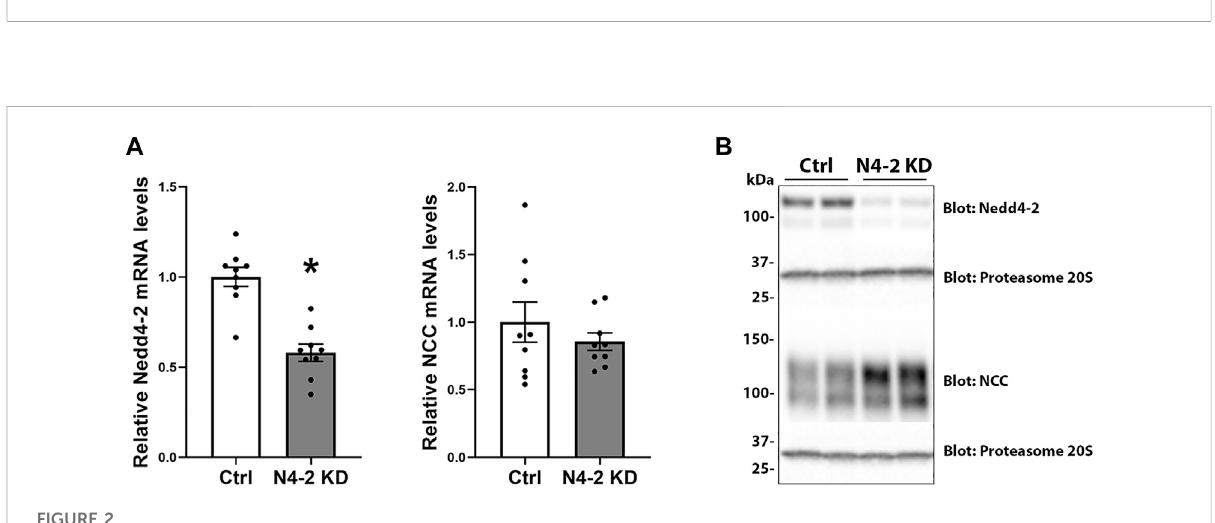
FIGURE 1 Nedd4-2interactswithNCC. (A) ThreeE3ubiquitinligaseswerefoundinaY2HassaywiththeC-terminusofNCCasbait.Nedd4-2,Nedd4,and Pdzrn3. The orange line represents the Selected Interaction Domain (SID), corresponding to the amino acid sequence shared by all prey fragments matching the same reference protein. (B) NCC immunoprecipitation (IP) of Nedd4-2 from MDCKI-hNCC cells. IP was performed using FLAG-M2 af fi nity beads and negative controls were performed in the absence of antibody (A,B) .